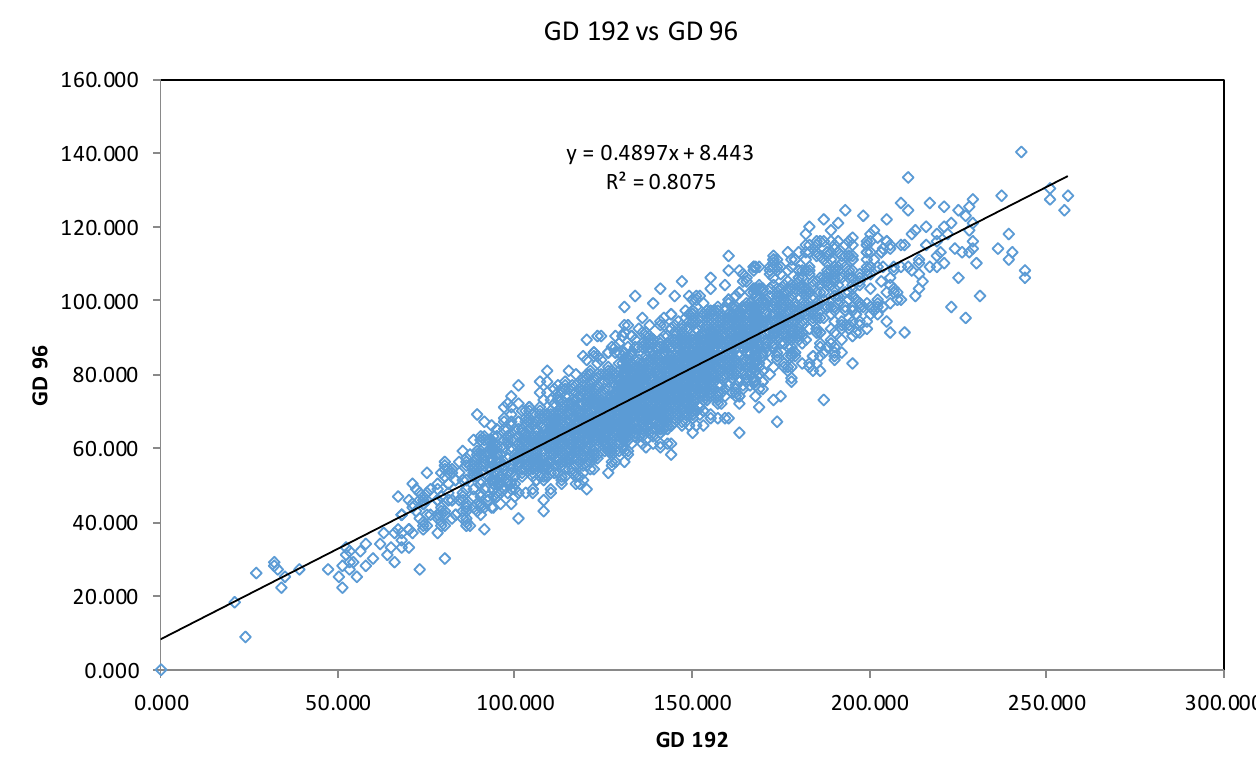
Figure 1. Mantel test of correlation between genetic distances generated by the full set of 192 SNPs and the selected core set of 96 SNPs.